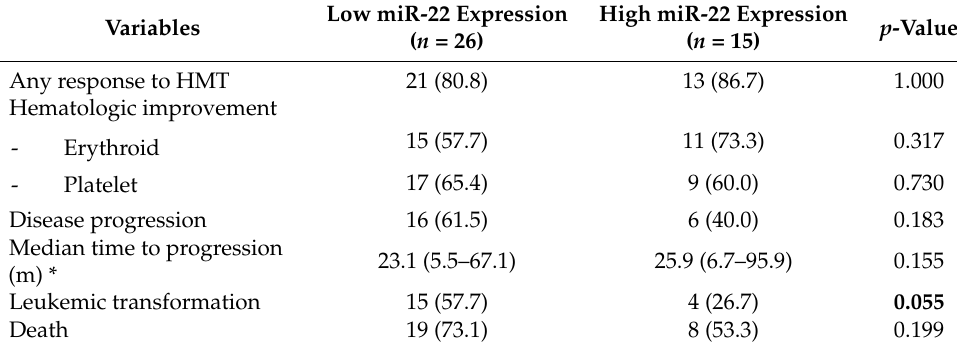
Table 4. Treatment outcomes of HMT according to miR-22 expression status.